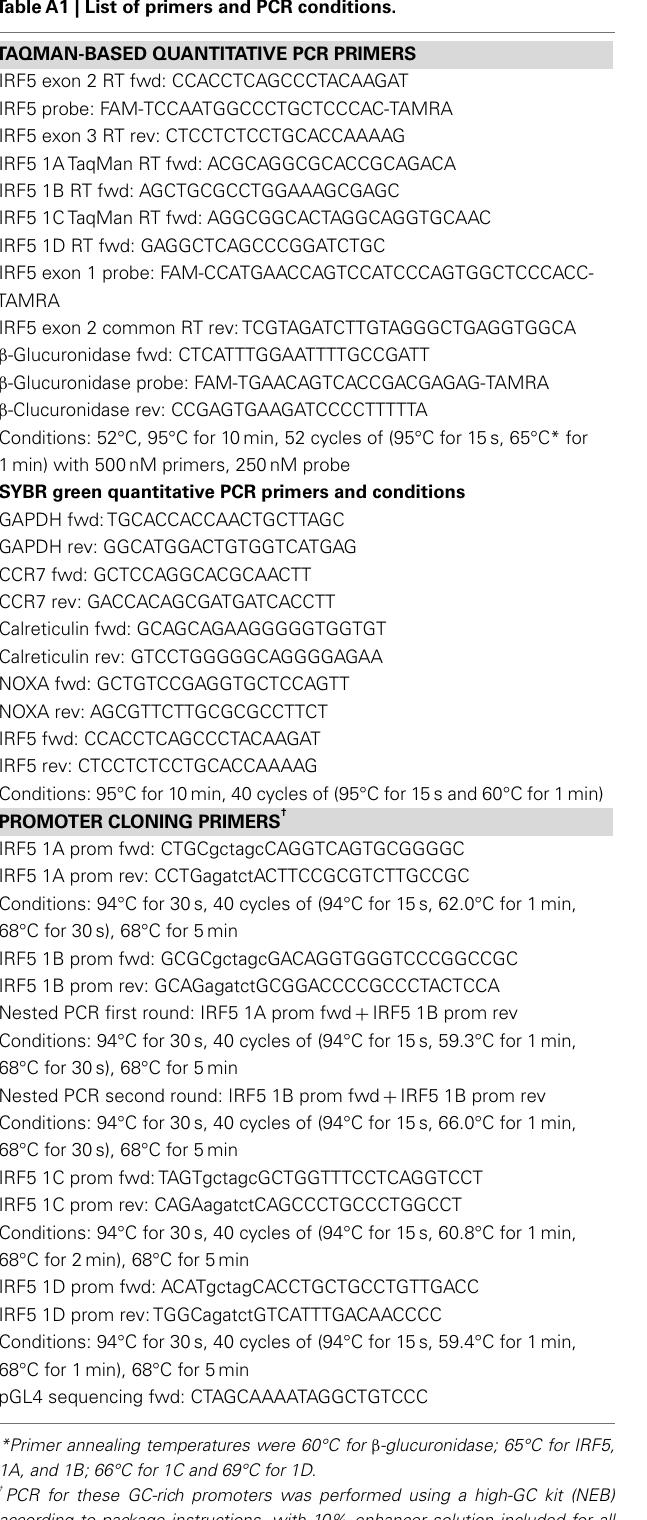
TableA1 | List of primers and PCR